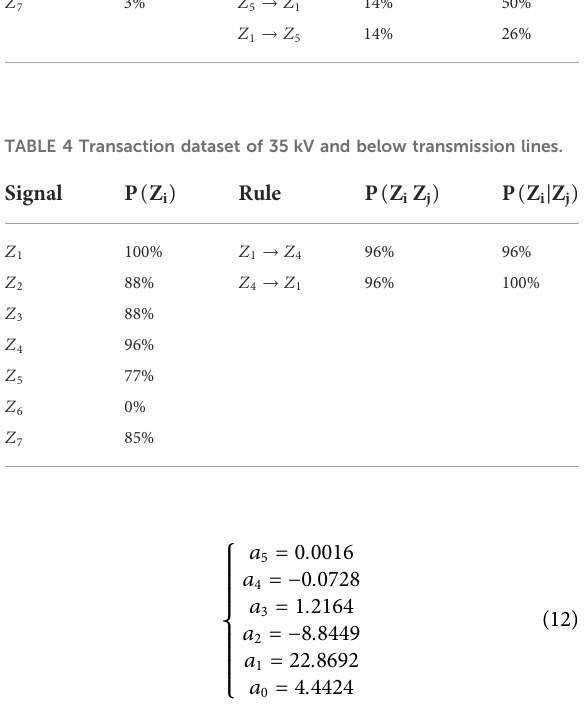
TABLE 6 Hourly distribution probability of wild fi